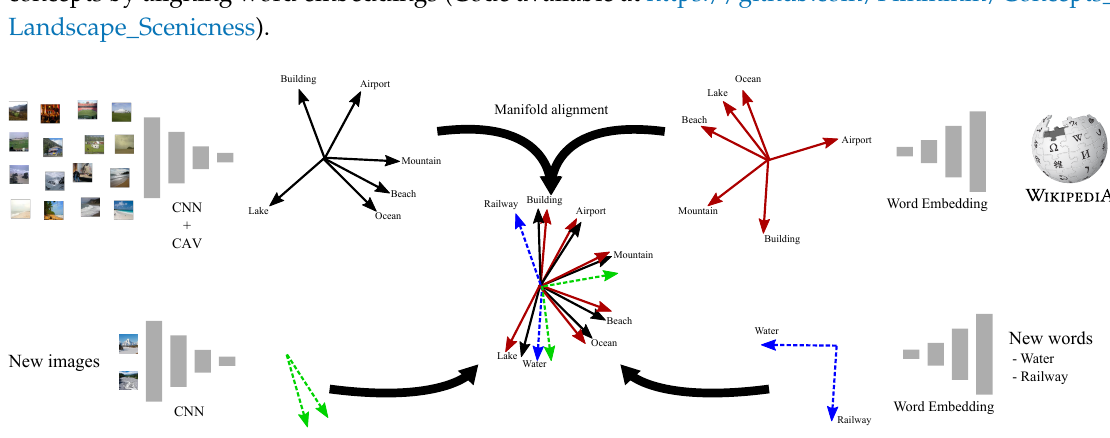
Figure 2. Overview of the proposed methodology. Concept Activation Vectors (CAVs) obtained using a visual dataset of concepts (top, left) are aligned with the corresponding word embeddings (top, right) using manifold